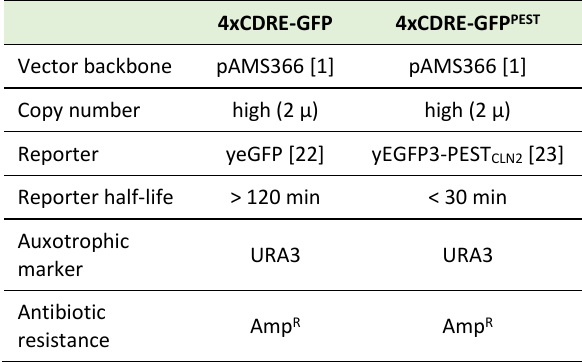
TABLE 1. Specifications for pAMS366-4xCDRE-GFP and pAMS366-4xCDRE-GFP PEST